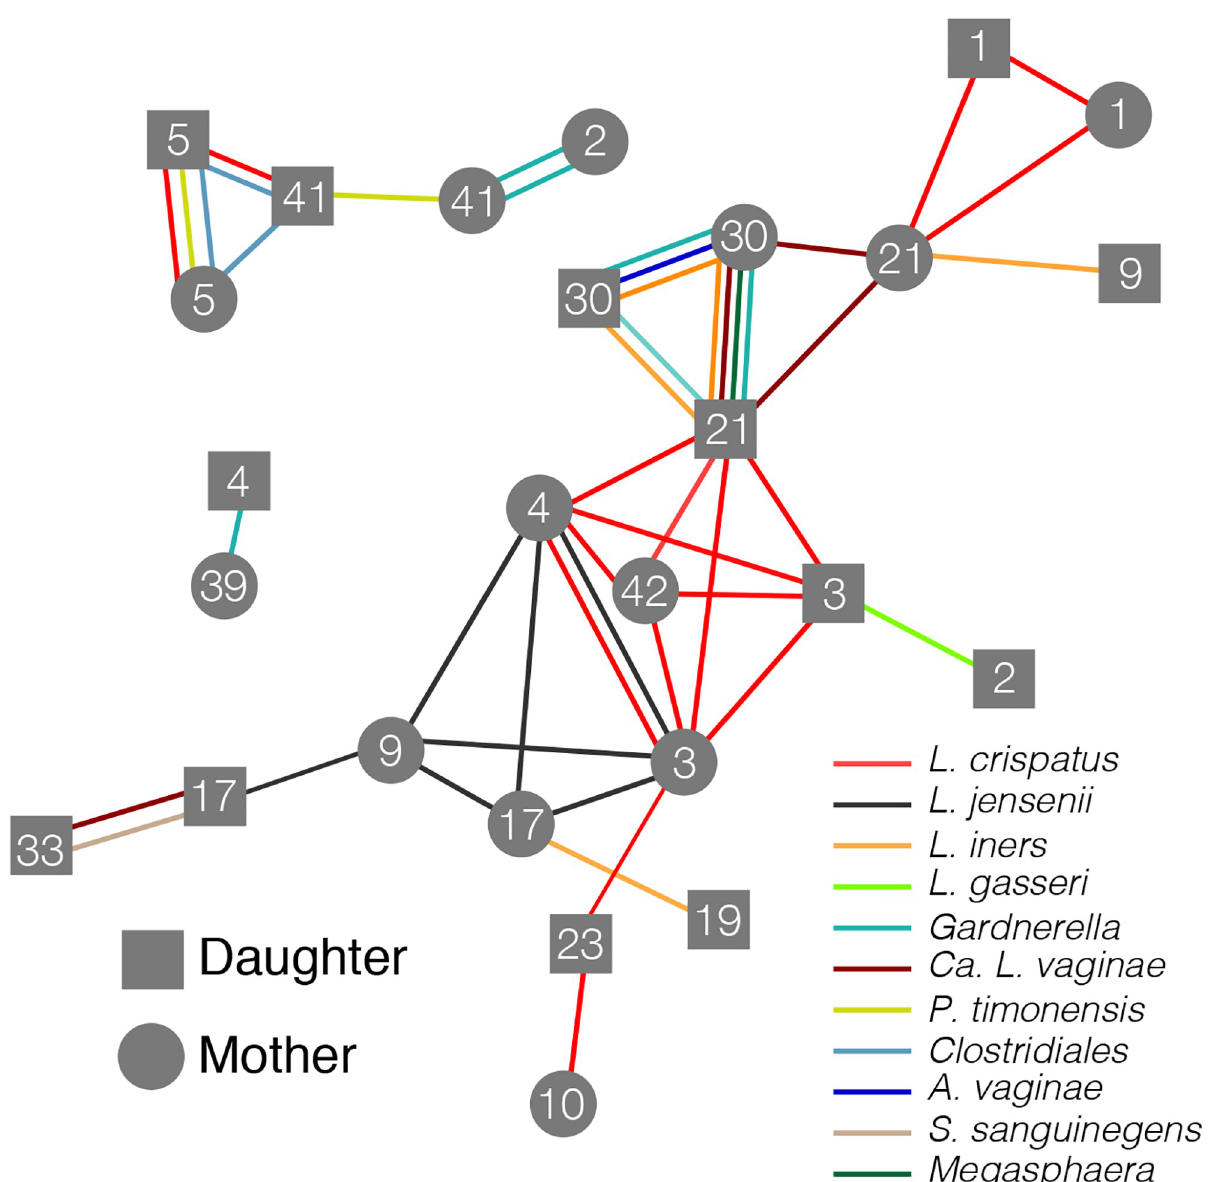
Fig 4. Network diagram of shared bacterial strains identified in this cohort. A stringent threshold, 99.9% sequence identity, 70% coverage, was used to identify shared strains. Lines represent the shared bacterial strains and connect the participants in which the strain was found. Mothers are represented by circles and daughters by squares. Numbers on the nodes signify the family and can be linked back to the taxonomic profile of the participant using Fig 1.